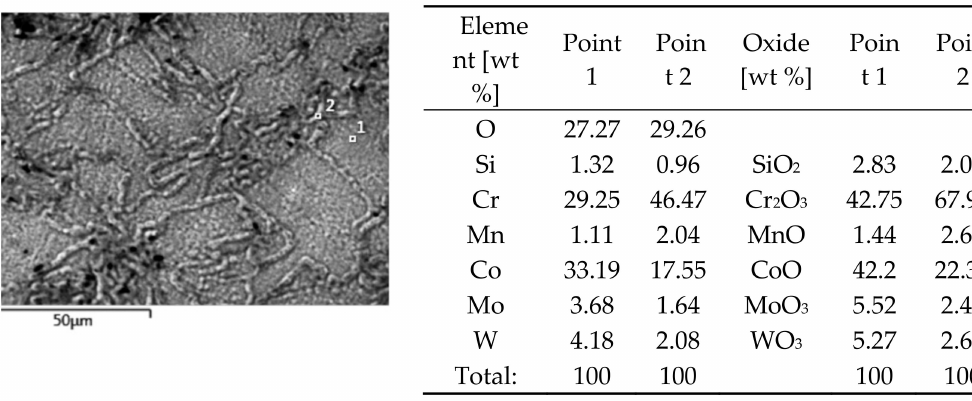
Figure 14. Results of EDS point analyses for the SLM2 sample after corrosion